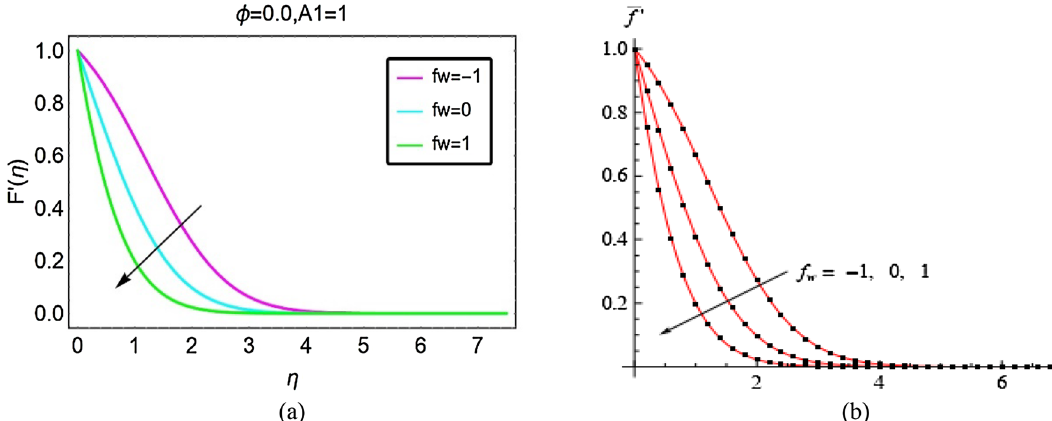
Figure 9. The pictorial comparative analysis for F ′ (η) 22 .